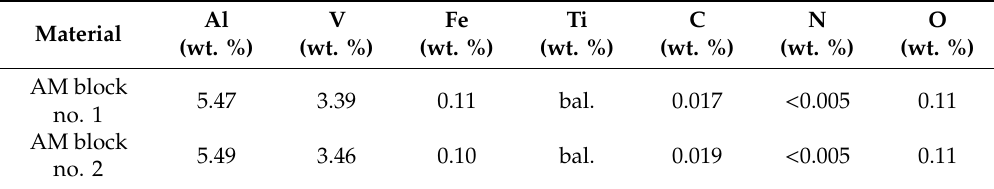
Table 5. Chemical composition of AM bulk